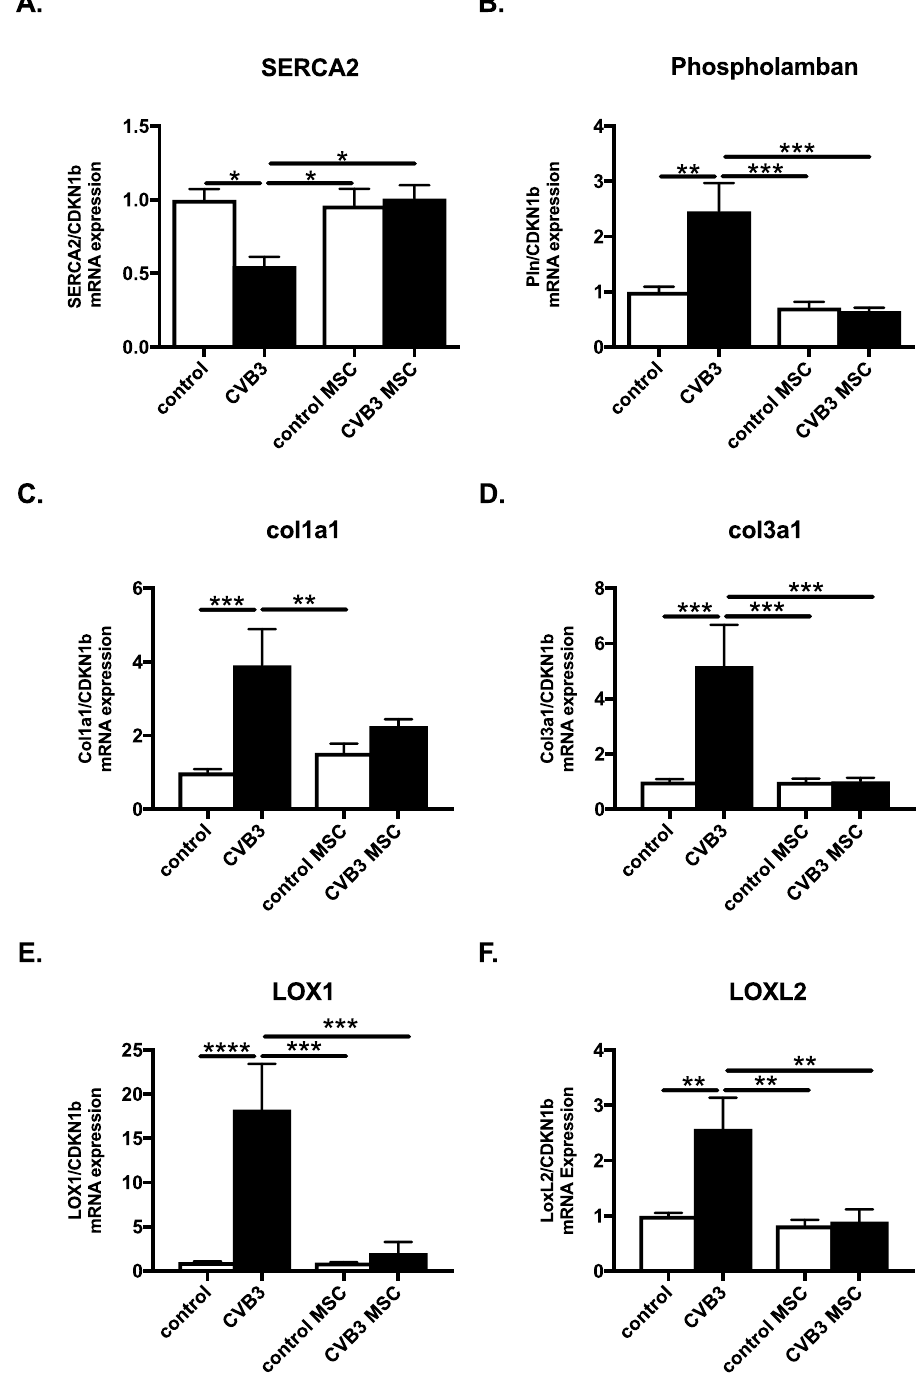
Figure 7. Mesenchymal stromal cells application in Coxsackievirus B3-infected mice improves the expression of genes important for cardiac contractility and fibrosis. Bar graphs represent the mean ± SEM of ( A ) SERCA2, ( B ) phospholamban, ( C ) Col1a1, ( D ) Col3a1, ( E ) LOX1 and ( F ) LOXL2 mRNA expression in the LV of control, CVB3, control MSC, and CVB3 MSC mice, as indicated, with n = 5–6/group and * p < 0.05, ** p < 0.01, *** p < 0.001, and **** p <